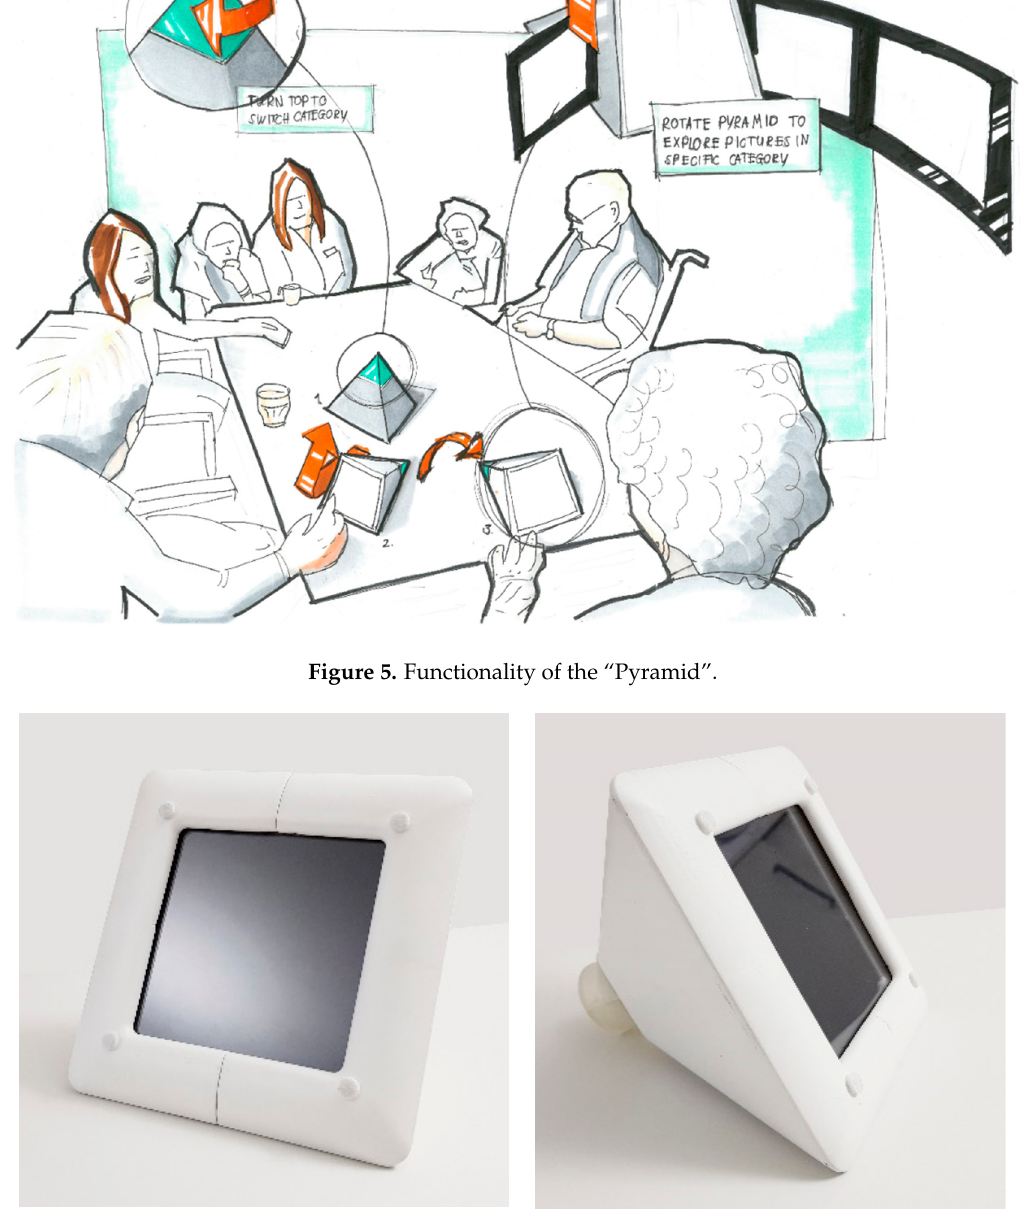
Figure 6 . The “Pyramid” prototype.